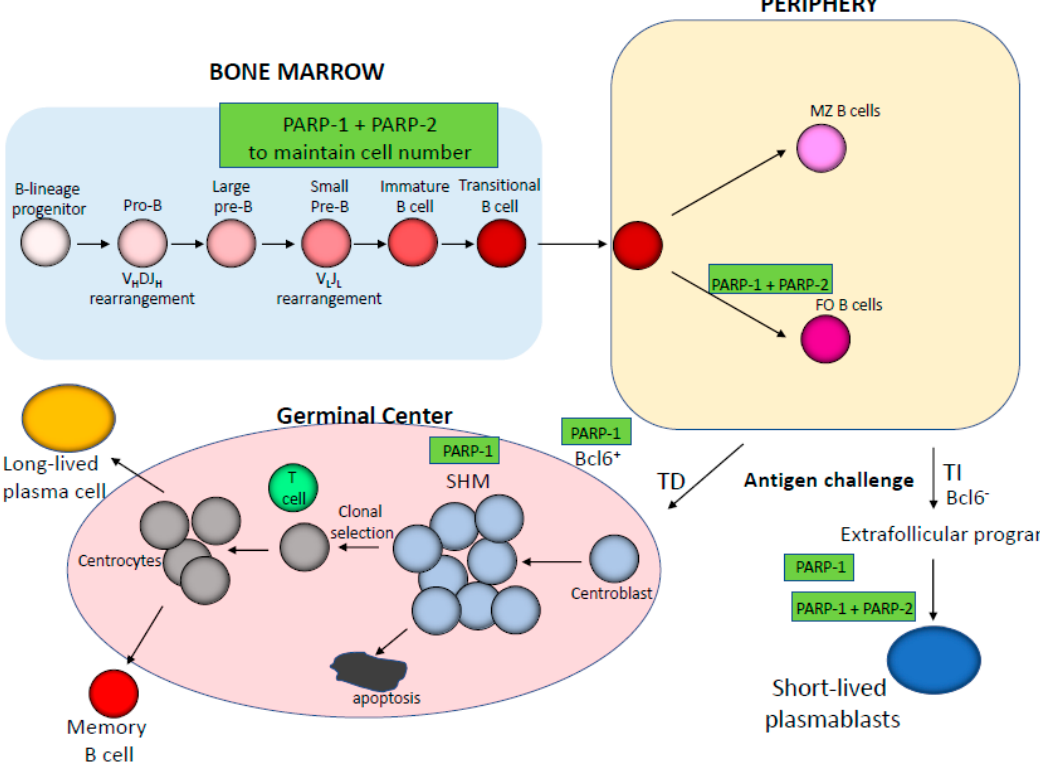
Figure 2. Schematic representation of B cell development depicting the specific stages in which PARP-1 and/or PARP-2 play a role. MZ, marginal zone; FO, follicular B cells; TD, T cell-dependent antigen; TI, T cell-independent antigen; SHM, somatic hypermutation.